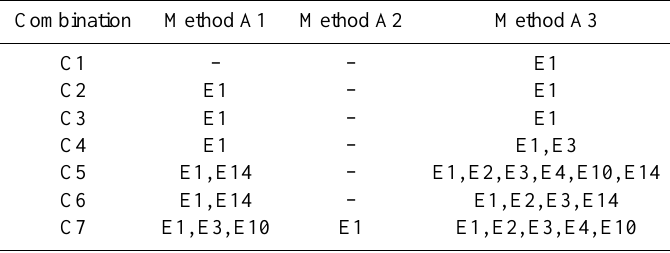
Table 5. Events detected (that is with DF( λ CF ) in GQDI not identically equal to zero) by all tested TEDA configurations, that are obtained by applying methods A1, A2 and A3 with different combinations of temporal parameters (see Table 3 for event codes and Table 4 for combinations).